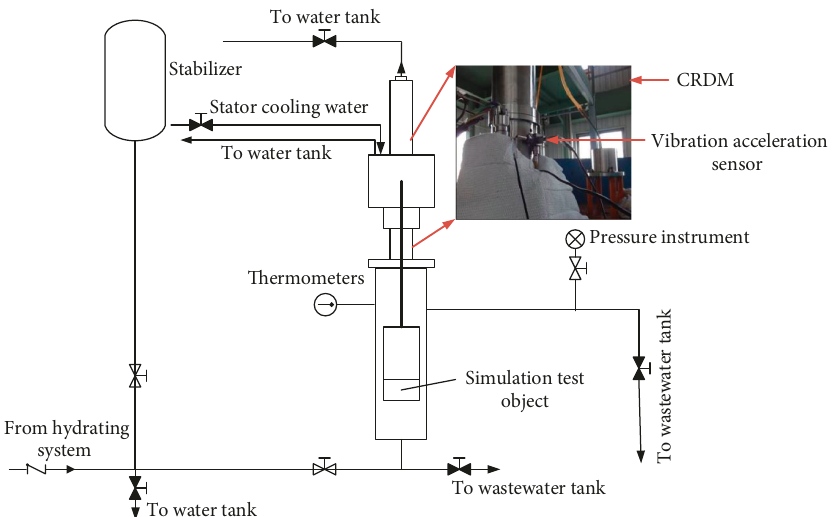
Figure 4: Schematic diagram of the CRDM full life test